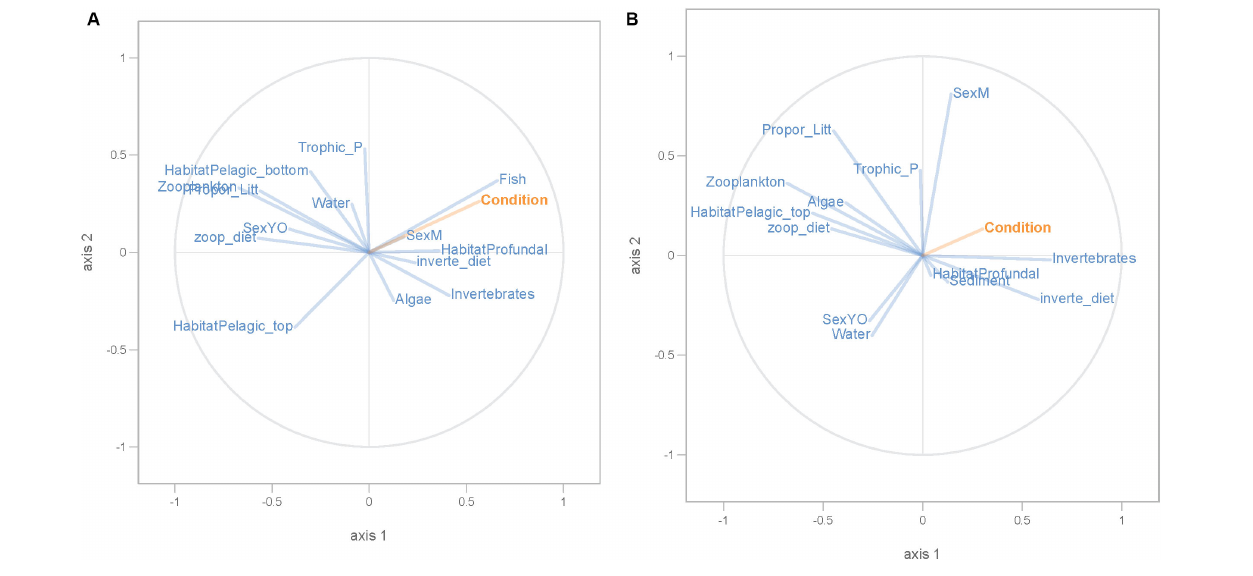
microbial communities that can locally adapt. One other